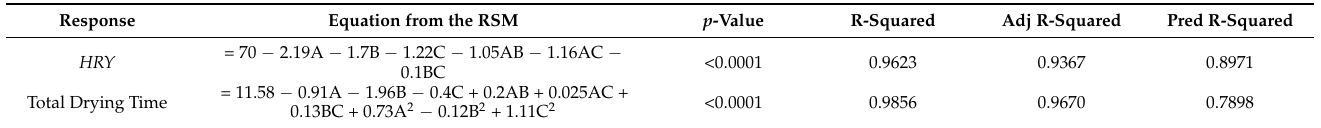
Table 4. The results of response surface